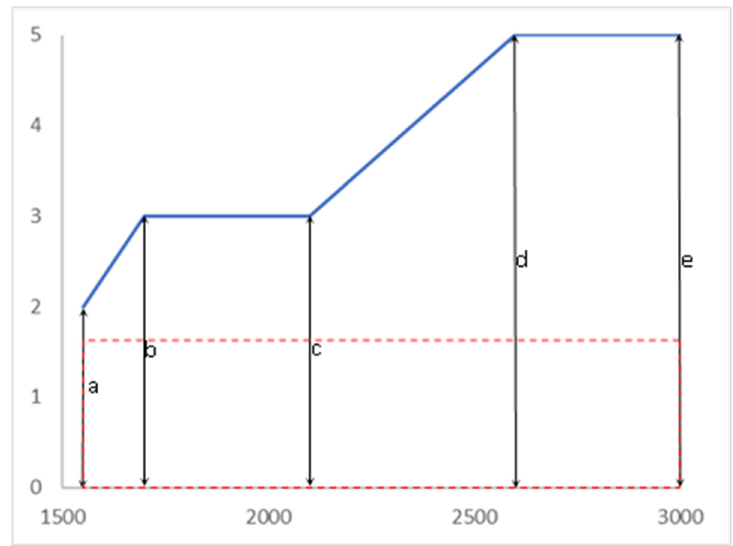
Figure 2. Illustrative example of computing an area score (percent maximum area, PMA) for the TDT25 from the polygon formed from the number of correct responses to each of the five comparison stimuli sets presented in the TDT25 protocol. The abscissa quantifies the stimulus dimension, while the ordinate quantifies the number of correct responses (out of 5) at each stimulus comparison level. The rectangle bounded by the red broken line illustrates the area that would be formed if each stimulus had a correct response rate of 1.66, i.e., the expected long-term rate of correct responding when guessing (NB In the three-alternative forced-choice protocol of the TDT25, the limen probability is (1.0 − 0.33)/2 = 0.67). The standard grid for each TDT25 stimulus anchor triplet is 1500 µm, and the fi ve comparison stimuli are 1550, 1700, 2100, 2600, and 3000 µm (indicated as a,b,c,d,e on the abscissa). The overall polygon is the sum of four component polygons, each bounded by the respective correct response frequency and the corresponding subtending stimulus distance. In the illustrated example, the area of the overall polygon (TDT25 PMA score) is the sum of the component polygon areas, which is 78.97% of the maximum possible area that would be obtained if all compar- isons had 5 correct responses out of the corresponding 5 trials.